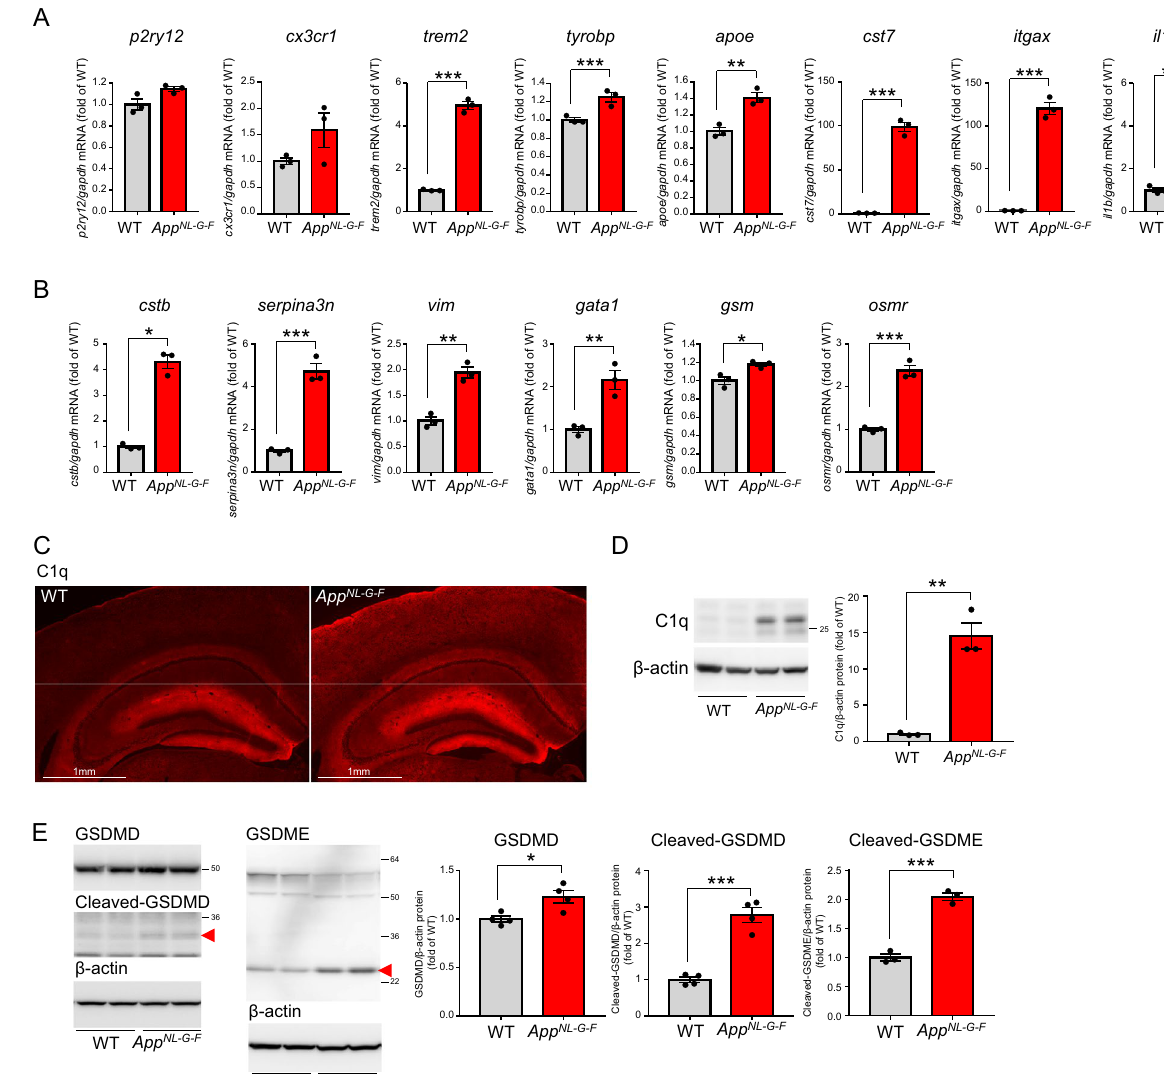
Figure 8. App NL-G-F mouse shows inflammatory events similar to that of GCLC-KO mouse. ( A,B ) mRNA levels of microglial ( A ) and astrocyte ( B ) markers in 12-month-old WT and App NL-G-F were determined. Values shown in the graphs represent the mean relative expression level ± SEM (n = 3; * p < 0.05, ** p < 0.01, *** p < 0.001). ( C ) Brain sections from 6-month-old WT (left panels) and App NL-G-F (right panels) were immunostained using C1q antibodies. ( D ) C1q protein levels in 6-month-old WT and App NL-G-F were determined. Values shown in the graph represent relative expression levels of C1q (n = 3; ** p < 0.01). ( E ) GSDMD and GSDME protein levels in 12-month-old WT and GCLC-KO mouse brains were determined. Red arrowheads show cleaved form (active form) of GSDMD and GSDME, respectively. Values shown in the graph represent relative expression level of each protein (n = 3 or 4; * p < 0.05, *** p <